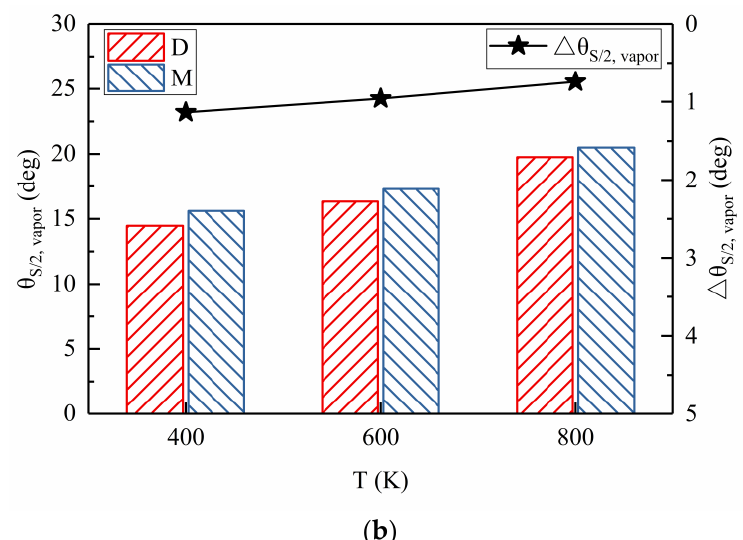
Figure 8. Quantitative results of vapor phase spray under different ambient temperature conditions. ( a ) Spray tip penetration results. ( b ) Spray angle results.